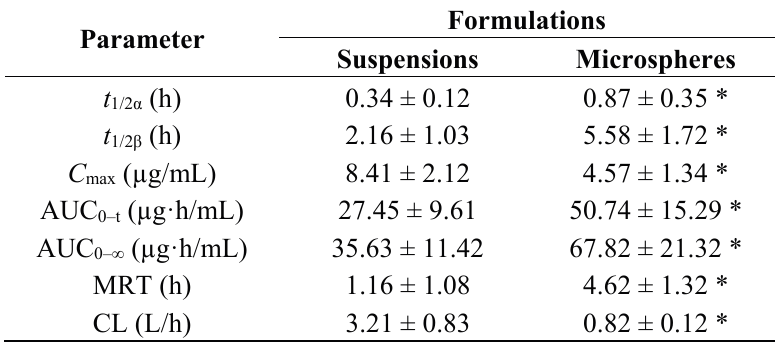
Figure 3. Mean plasma concentration time profiles of BUD after intragastric administration of a single 3.5 mg/kg dose of the suspension and microspheres to rats (each point represents the mean ± SD of six rats) Table 1. Pharmacokinetic parameters of the two formulations. MRT, mean residence time; CL,